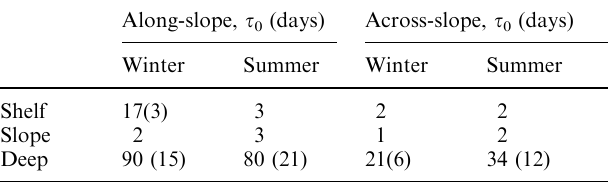
Table 2. Lagrangian correlation length scales, n second zero crossing in C ( n ), or where there are no zero crossings, as the second minima in C ( n ).